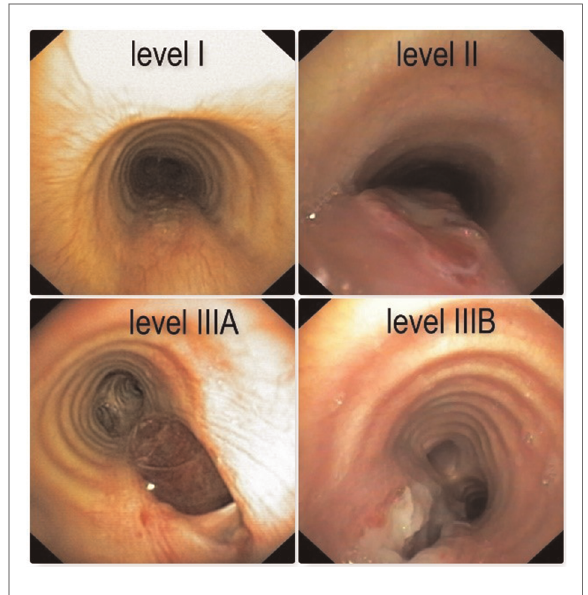
FIGURE 1 Photograph depictions of PITL level I, level II, level IIIA and level IIIB.